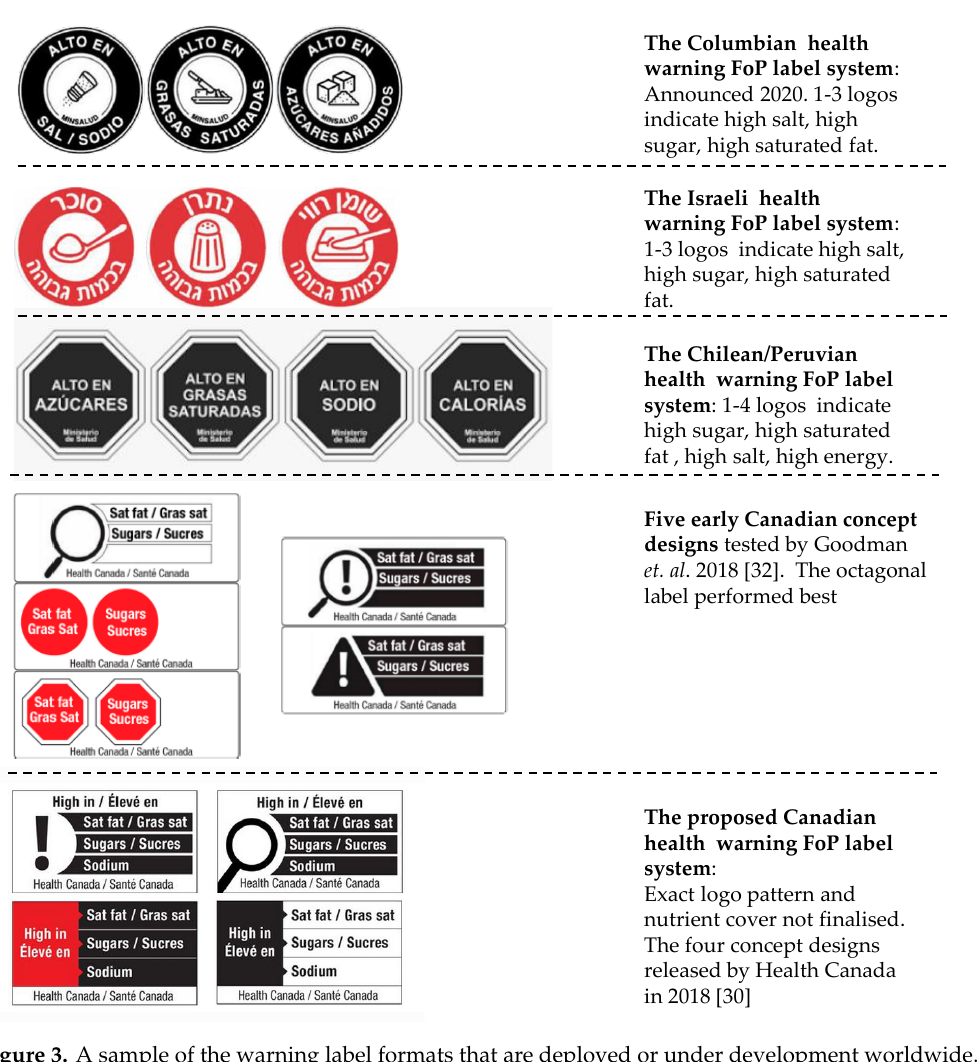
Figure 3. A sample of the warning label formats that are deployed or under development worldwide.